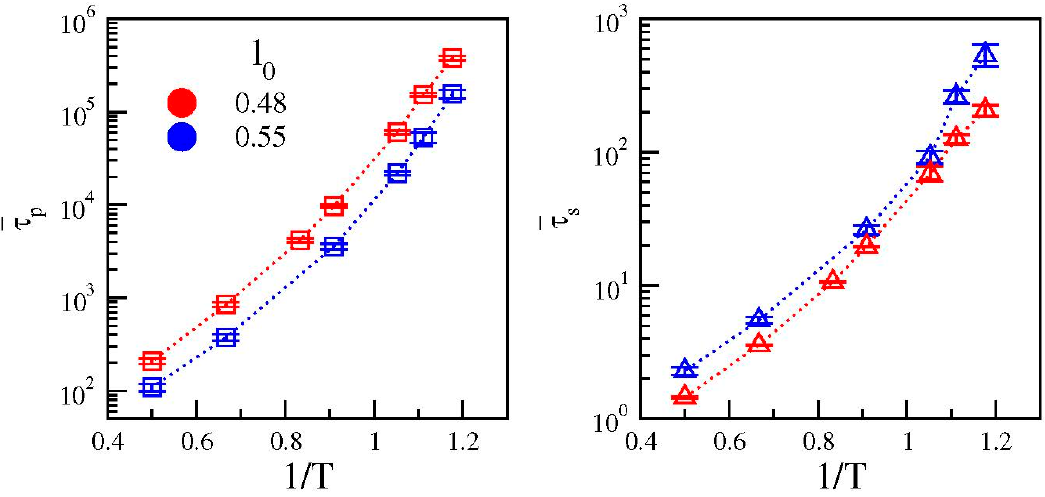
Figure 5. Arrhenius plots of the average relaxation times of the primary ( τ p , left) and secondary ( τ s , right) relaxations. Color code as in Figure 1.